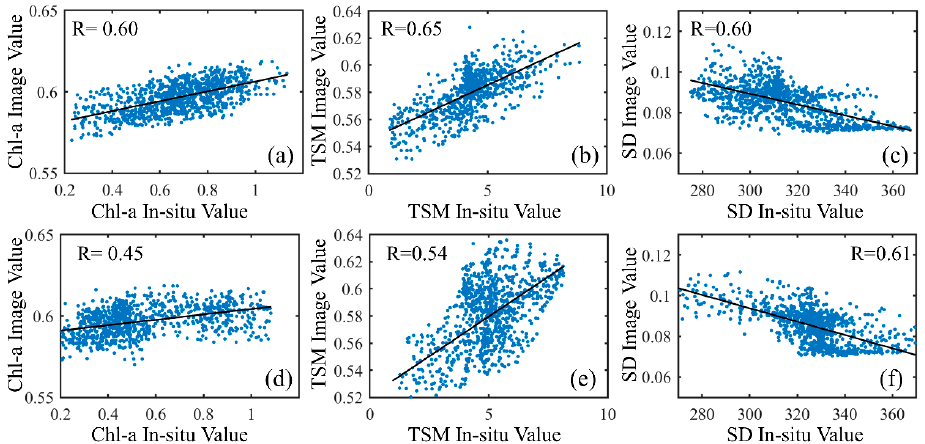
Figure 11. The Spearman correlation coefficient of multi-parameter sampling design method and systematic sampling method, Chl-a ( a , d ), TSM ( b , e ), SD ( c , f ).